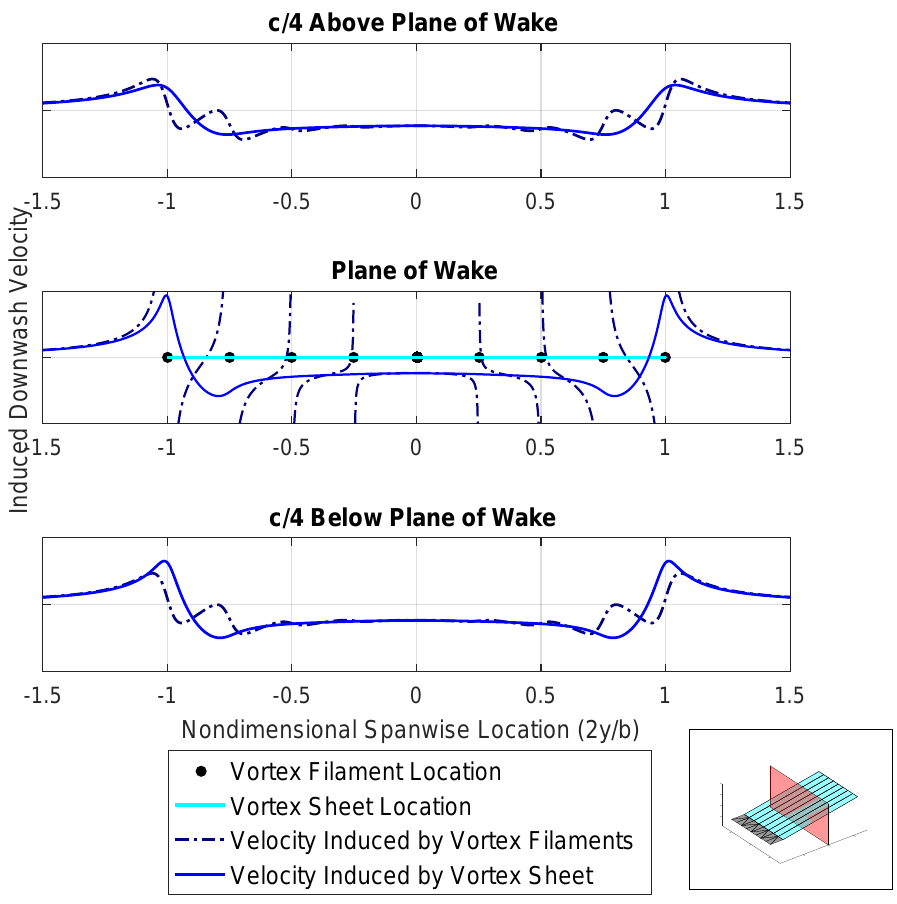
Figure 4. Wake-induced velocities from a vortex lattice method, as well as a higher-order continuous vorticity method. The lower inset shows where the velocities were found